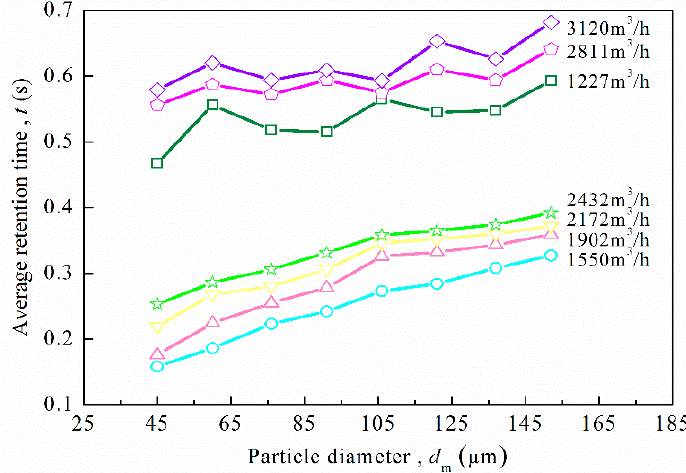
Figure 8. Influence of reverse-blowing flow rate on the average retention time.